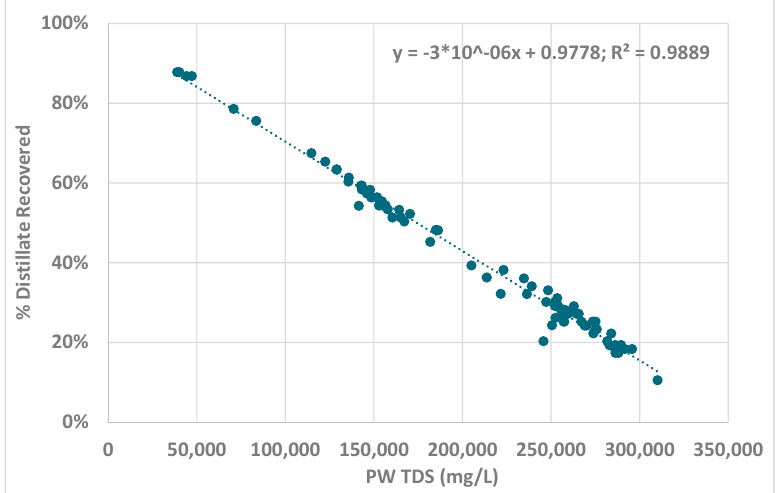
Figure 2. Modelled distillate recovery as a function of PW TDS using an MLD approach.